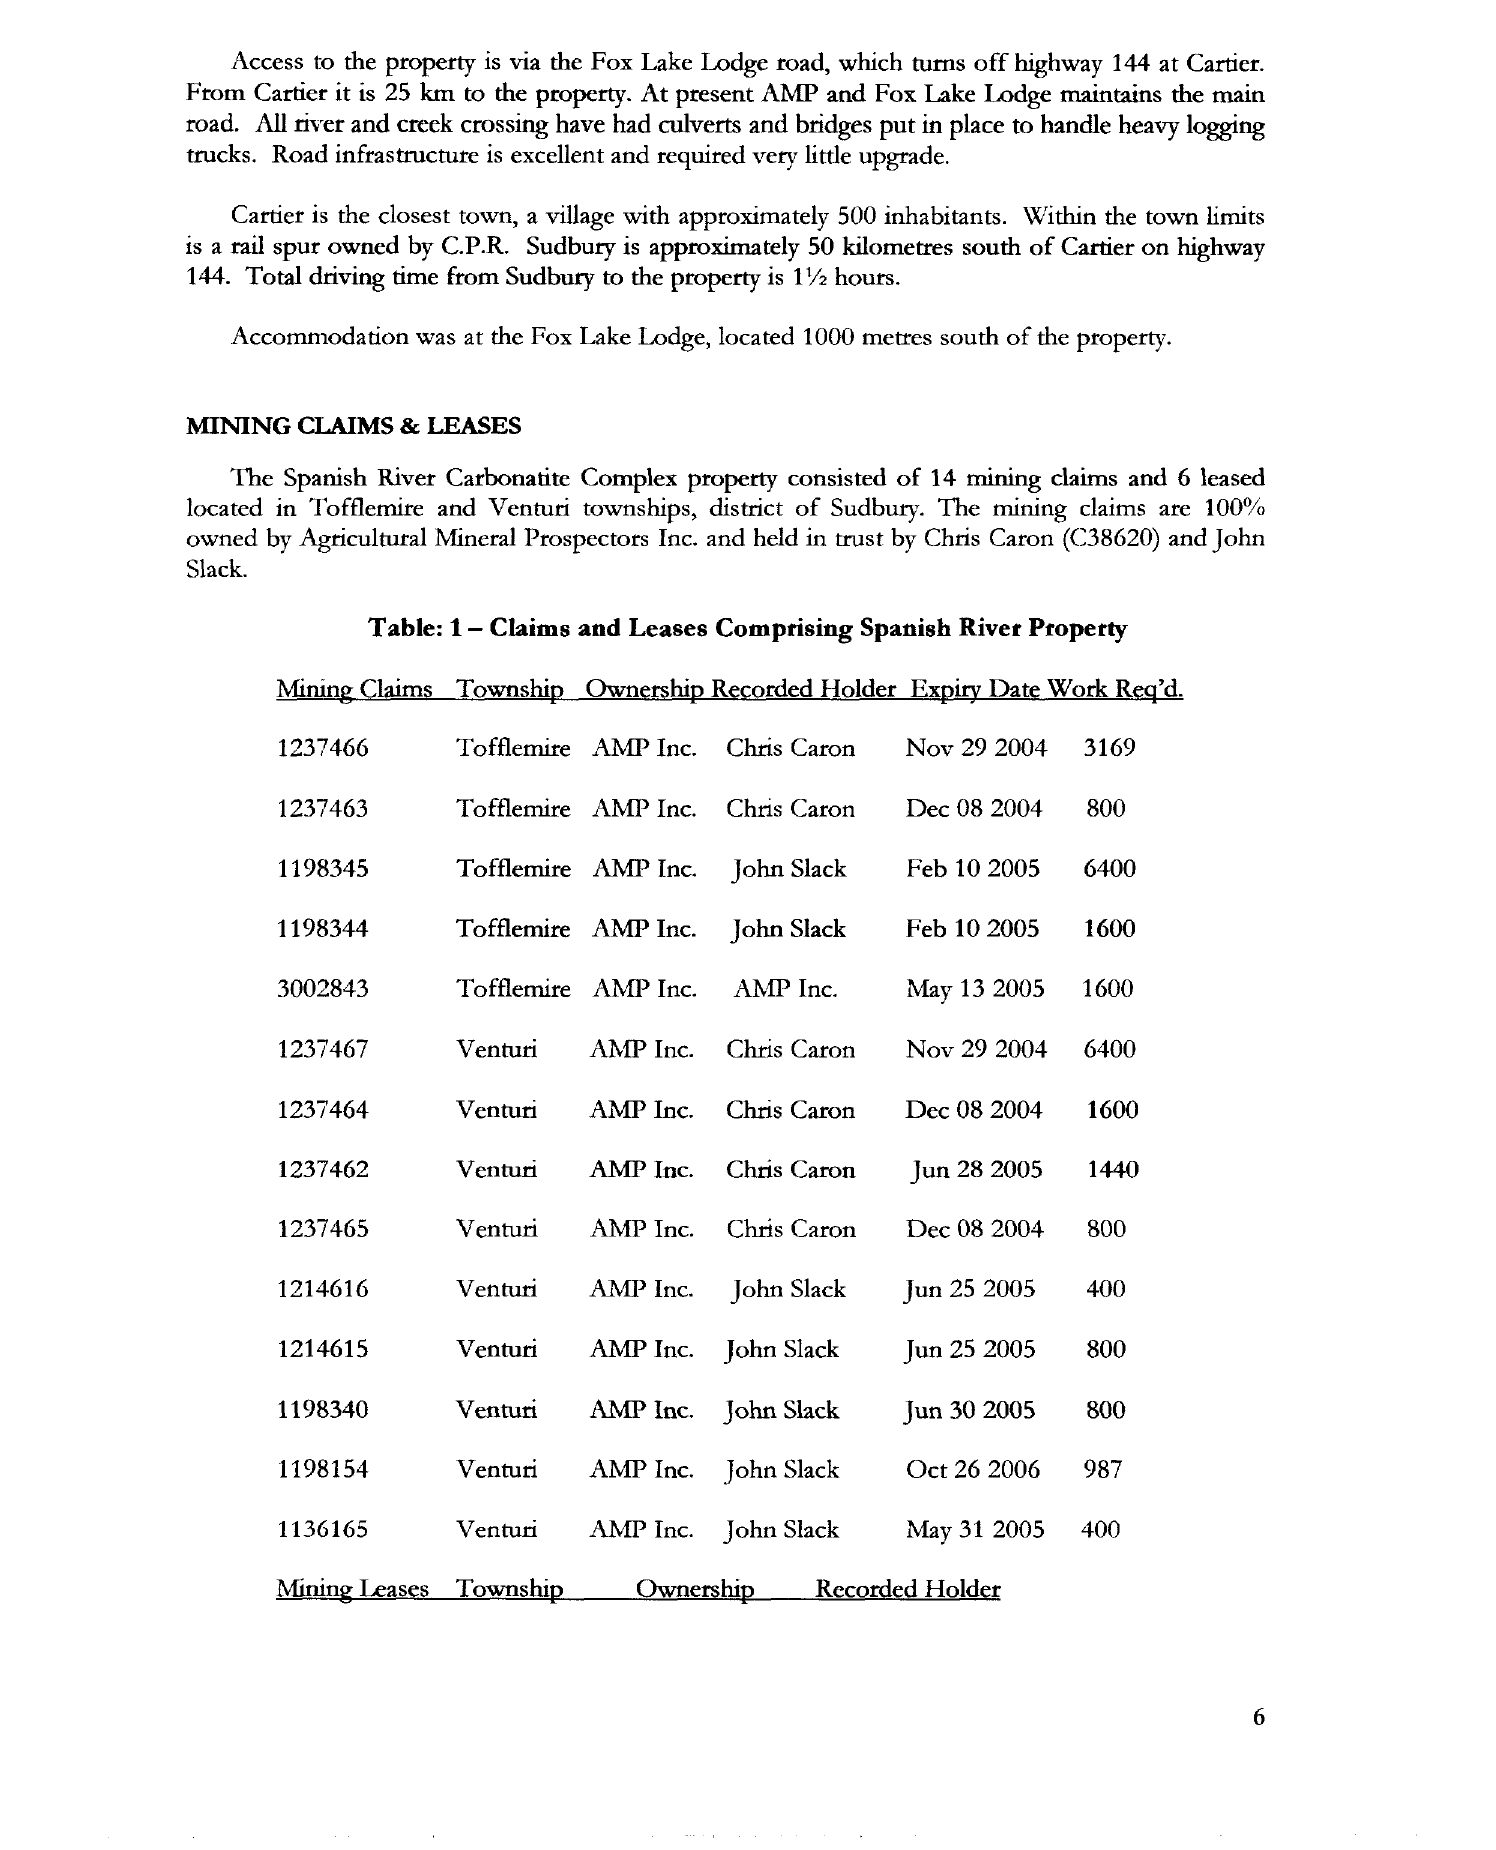
Table: l — Claims and Leases Comprising Spanish River